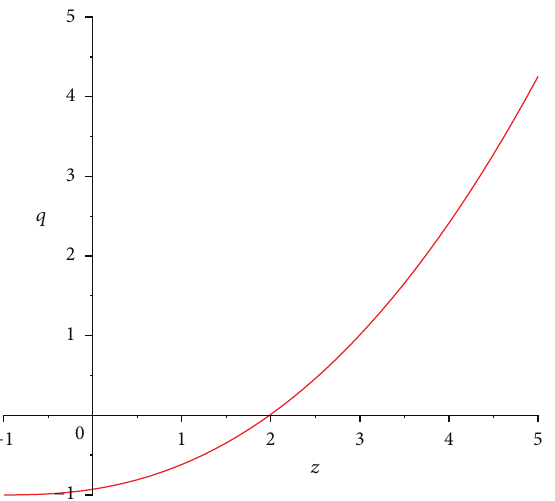
Figure 3: Variation of effective equation of state parameter versus theredshiftforaspecific 𝑓(𝑅) modeldescribedas(33)with 𝑛 = 0.25 .